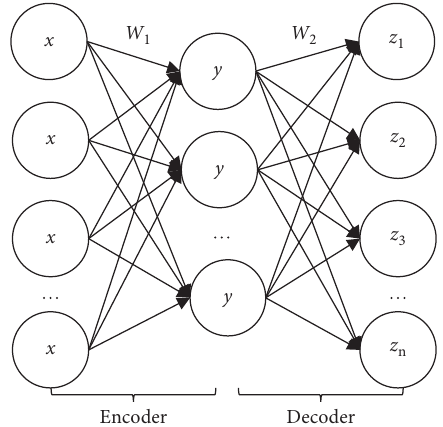
Figure 4: Typical autoencoder